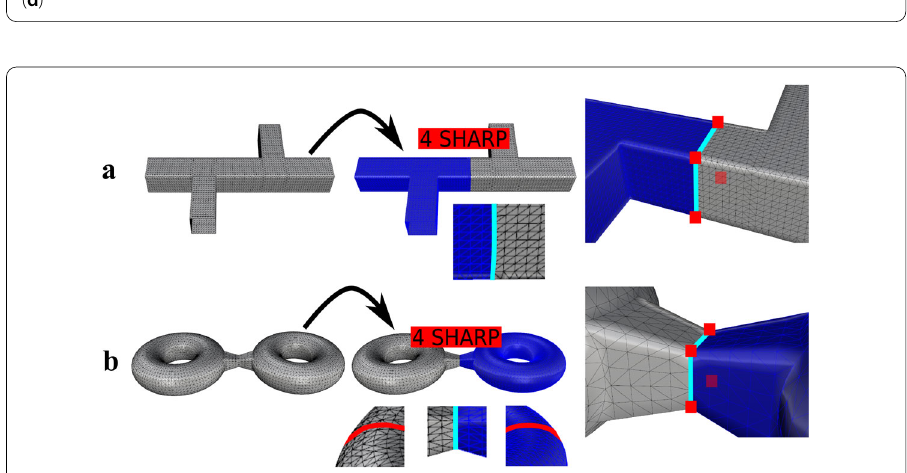
Fig. 5 Geometry-aware pants decomposition with feature points. Double T ( a ) is decomposed into pants using 4 feature points given by the user or determined automatically. A 2-torus pants decomposition